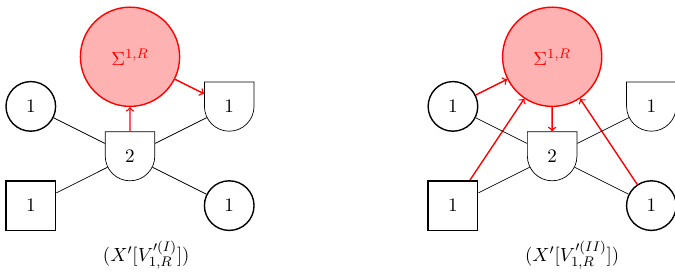
for the quiver gauge theory 1 ,R